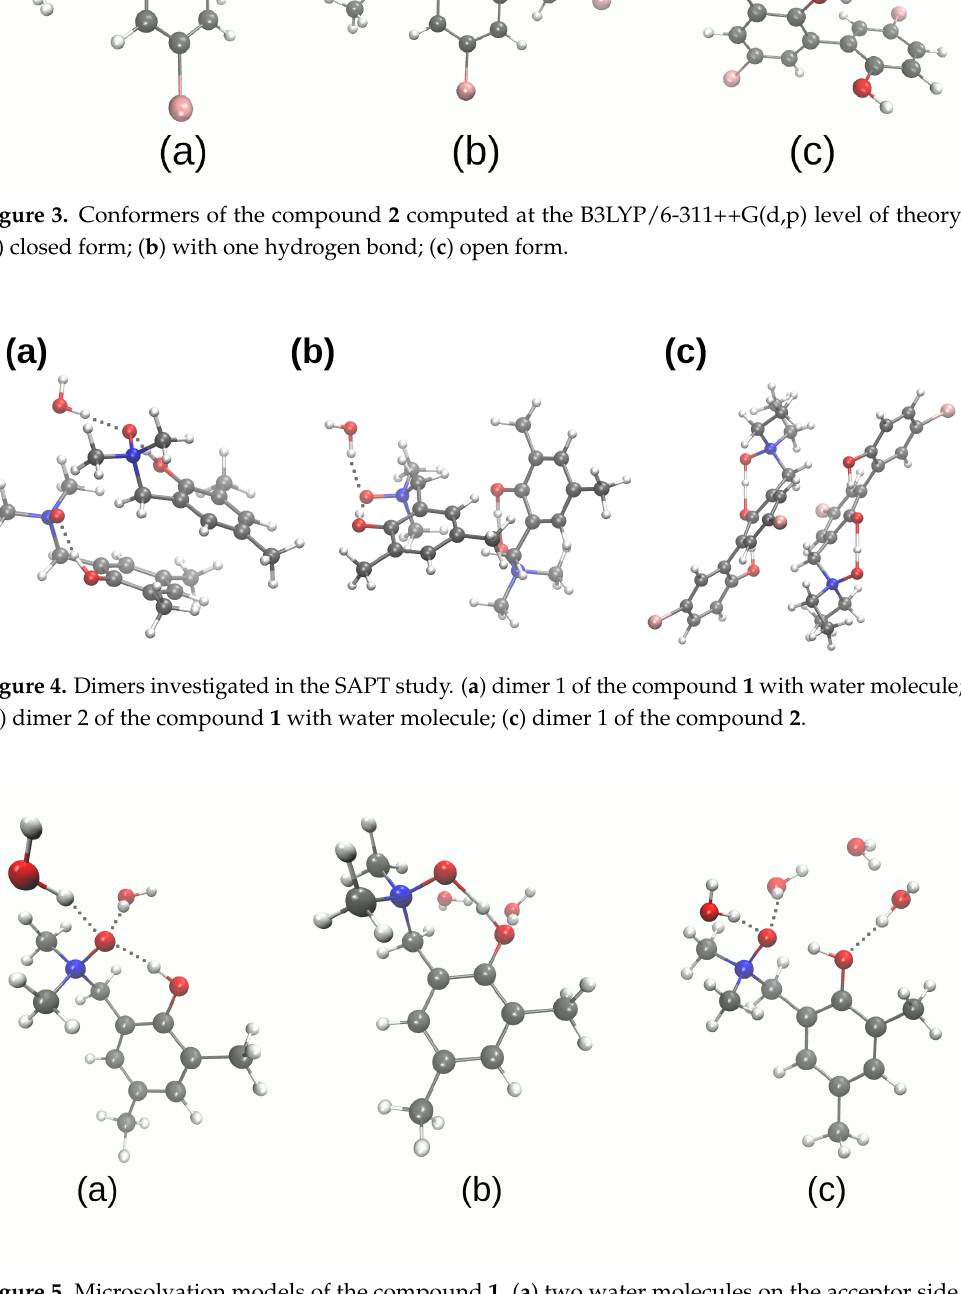
Figure 5. Microsolvation models of the compound 1 . ( a ) two water molecules on the acceptor side, 1 -A2; ( b ) one water molecule on the acceptor side and one on the donor side, 1 -AD; ( c ) four water molecules, two on the acceptor and two on the donor sides, respectively, 1